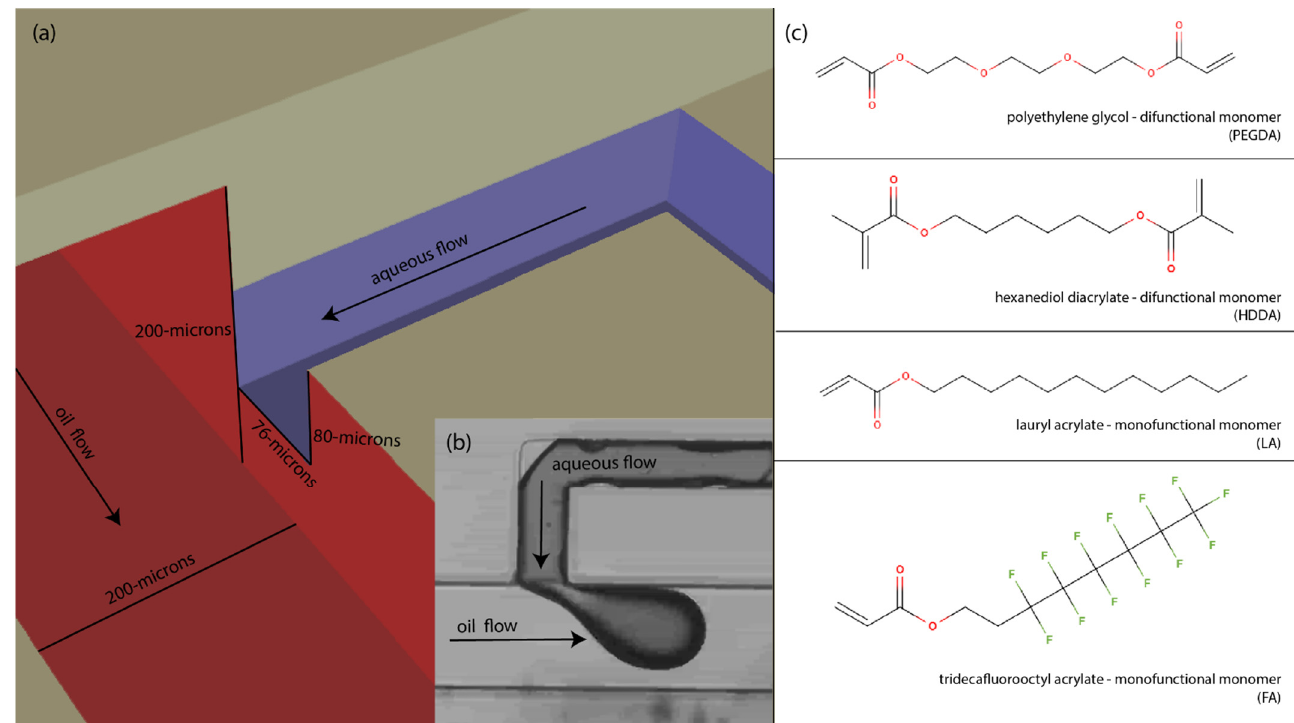
Figure 2. T ‐ junction geometry and monomer chemistry: ( a ) Schematic of cutout cross section of the T ‐ Junction droplet generator with the appropriate dimensions of the oil and aqueous flow channels. ( b ) Micrograph of dyed aqueous fluid forming droplet during operation. In this top ‐ down view the width of the aqueous channel is 76 μ m and the width of the oil channel is 200 μ m. ( c ) The four photopolymerizable acrylate monomers used in study, including the 3D printing polymer (PEGDA) and the three monomers used for surface treatment (HDDA, LA,